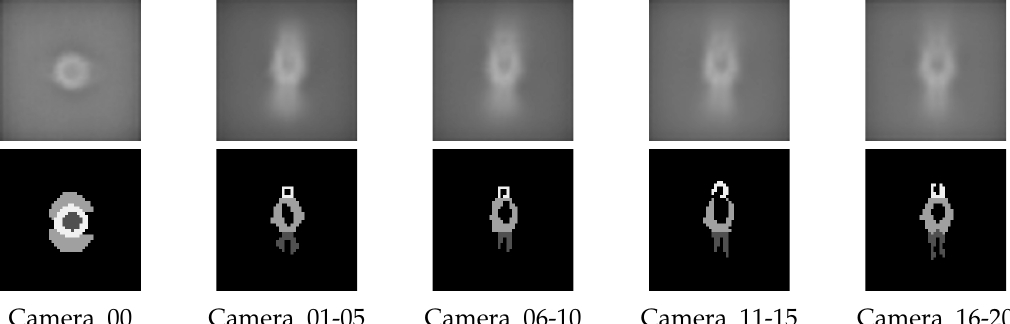
Figure 12. Average edge maps and labeled edge maps according to shooting orientations. Top and bottom images represent average and labeled-edge maps, respectively.